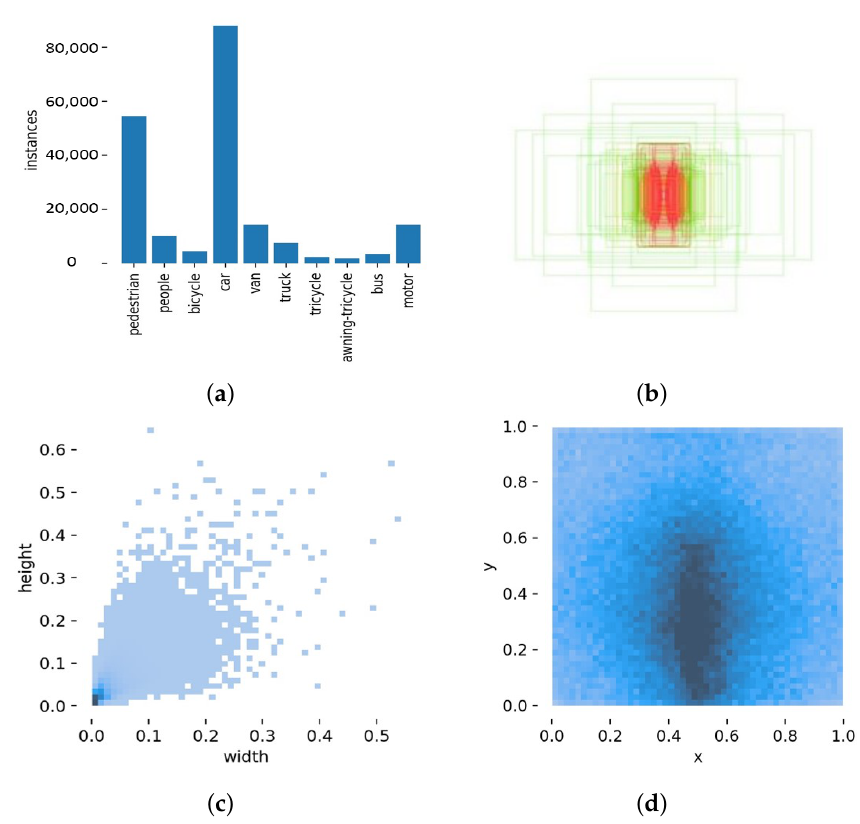
Figure 6. Details of the Visdrone dataset: ( a ) number of labels in various categories; ( b ) visualization plot of all labeled boxes aggregated at the center; ( c ) statistical plot of the width and height of all labels; ( d ) heat map of all labels occurring at the image